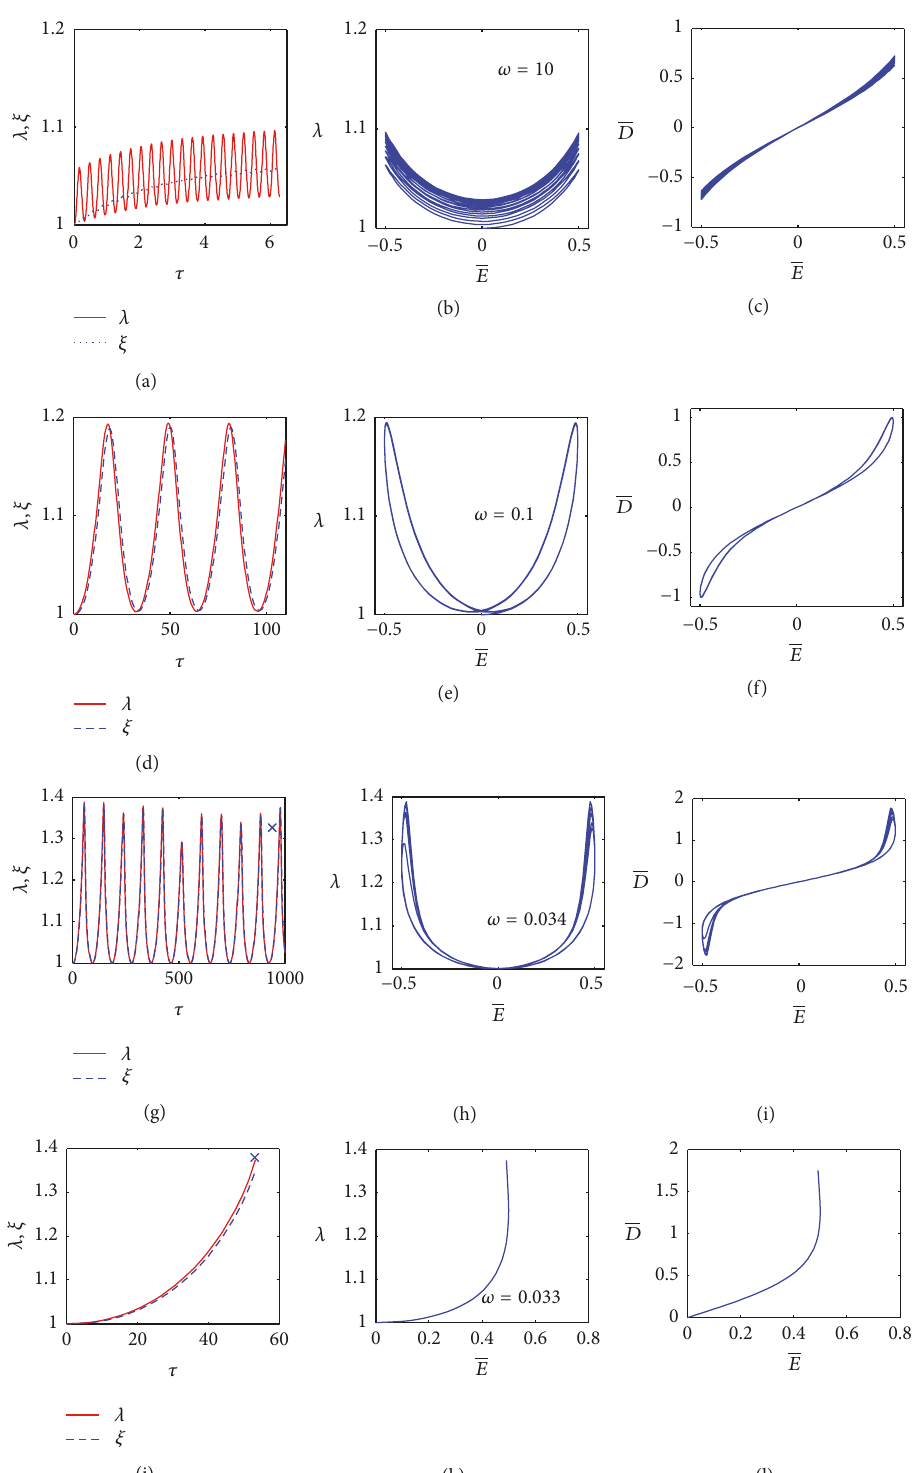
Figure 3: A membrane is subject to the applied cyclic nominal electric field. (a), (d), (g), and (j) are the calculated time-dependent total stretch and inelastic stretch. (b), (e), (h), and (k) are the stretch-electric field response. (c), (f), (i), and (l) are the dimensionless nominal electric displacement-nominal electric field curves. Four different dimensionless frequencies are used in the calculation with 𝜔 = 10 for (a), (b), and (c), 𝜔 = 1 for (d), (e), and (f), 𝜔 = 0.034 for (g), (h), and (i), 𝜔 = 0.033 for (j), (k), and